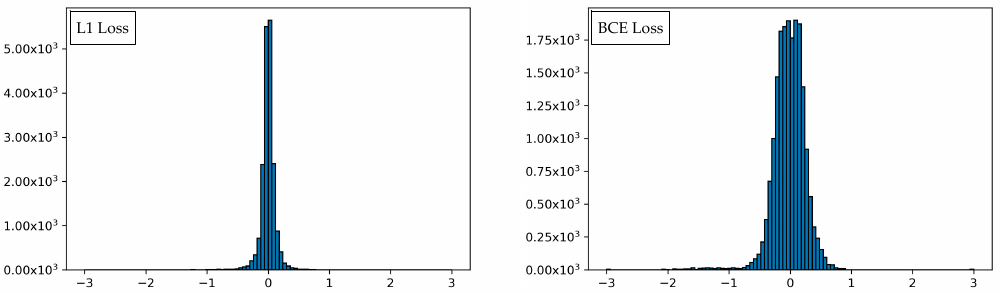
Figure 6. The parameter weight distribution of the CycleNets trained with L1 loss (left) and BCE loss (right).